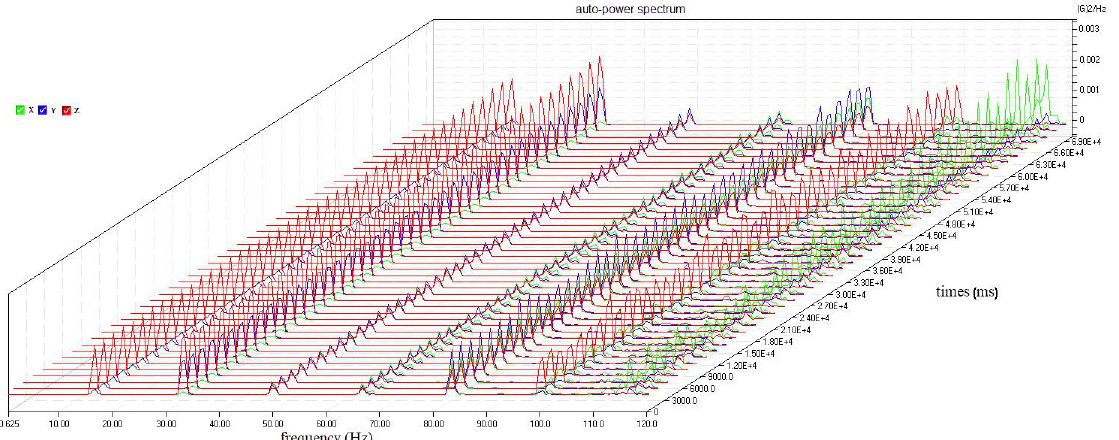
Figure 8. Waterfall diagram of the auto-power spectrum for an unbalanced